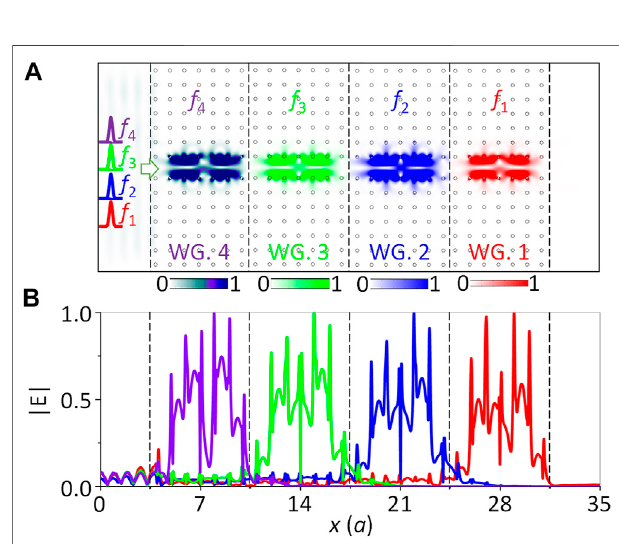
FIGURE 8 | Slow light rainbow trapping in frequency domain. (A) f 4 (cid:1) 4.1032 GHz, f 3 (cid:1) 4.1314 GHz, f 2 (cid:1) 4.1614 GHz, and f 1 (cid:1) 4.1902 GHz. (B) Normalized electric fi eld intensities along the lower boundary for different frequencies.Theinterfacesofadjacentwaveguidesegmentsaremarked as the black dotted